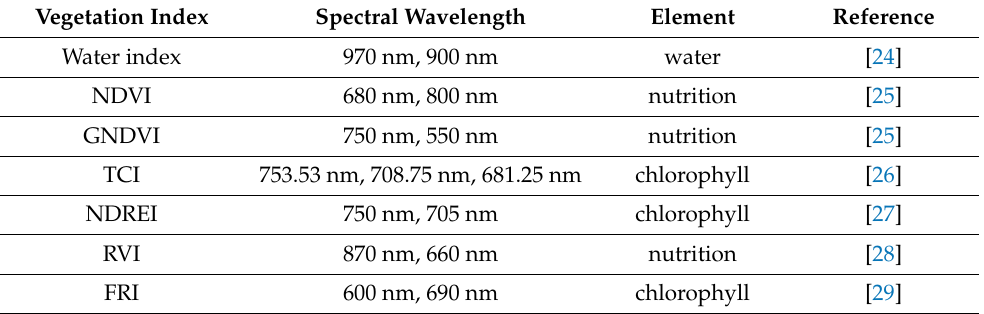
Table 2. Vegetation